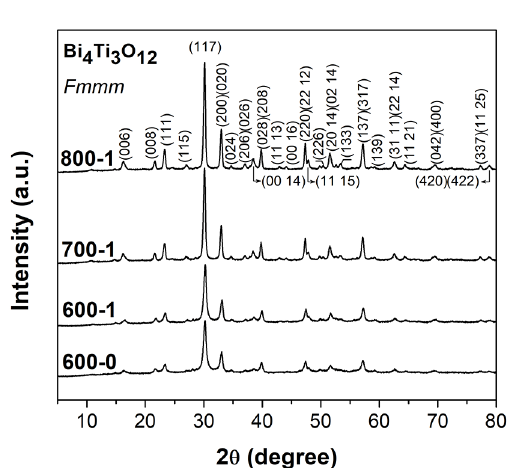
Ti O powders synthesized by 4 3 12